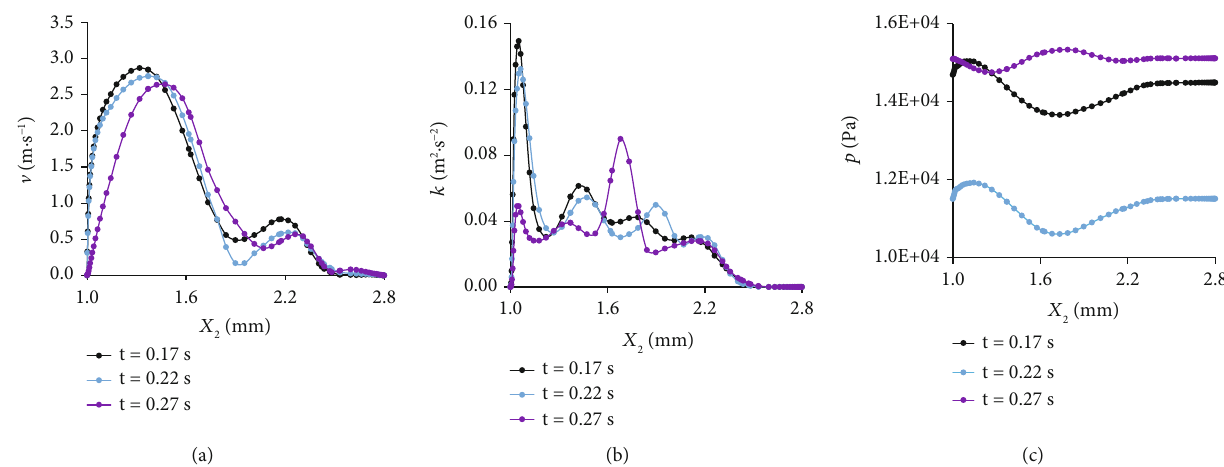
= 40mm : (a) velocity; (b) turbulent kinetic energy; (c) pressure. 1